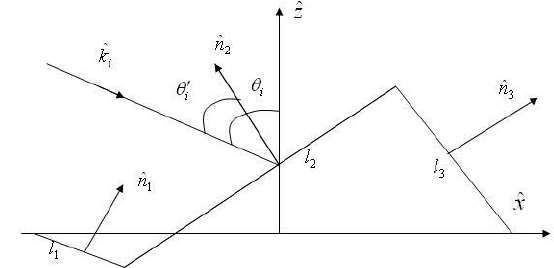
are the unit polarized vector of basic coordinate system and local coordinate system respectively. is the local incident angle. Due to avoid self-shadowing effect, the integral limit of z kx in Eq. (46) is from -cot θ i to ∞.